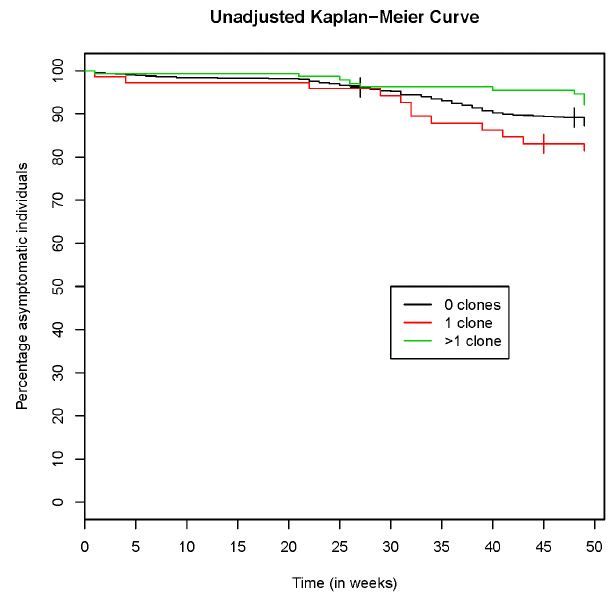
Figure 3. Kaplan Meier estimate (unadjusted) of time to subsequent clinical episode (fever and any P. falciparum ) in 1856 asymptomatic children.